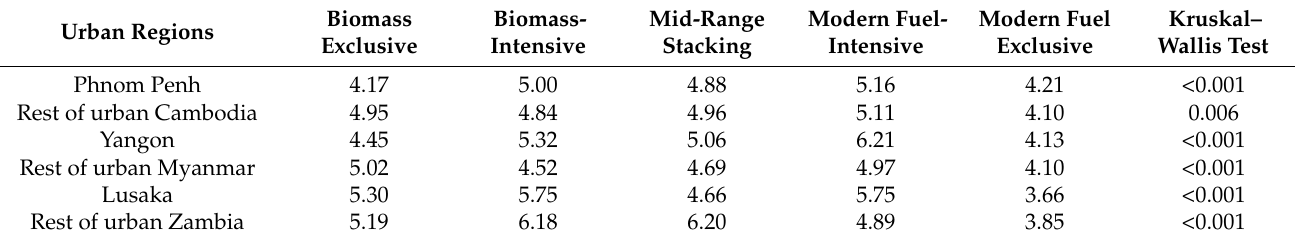
Table 10. Mean household